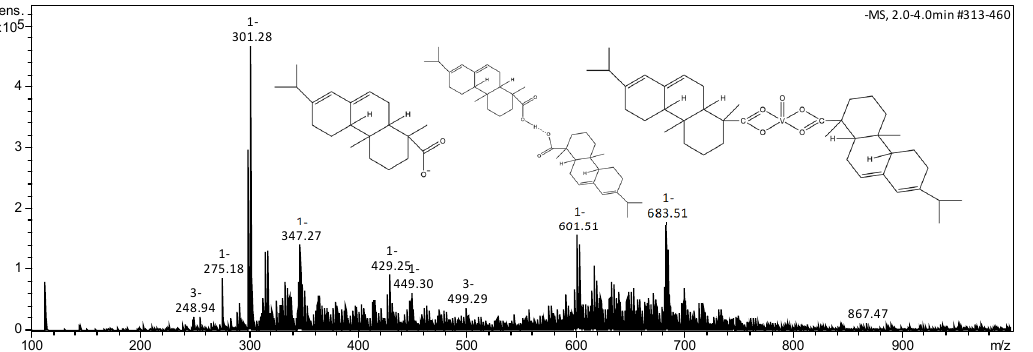
Figure 2. Mass spectra of VO(IV)- bis (abietate) with suggested molecules. In the interval from m/z 1–601.51 to 1–683.51, there was a characteristic progression with an m/z difference of 16 units, corresponding to an oxygen atom related to oxidation at the C–C bonds to the corresponding keto forms.